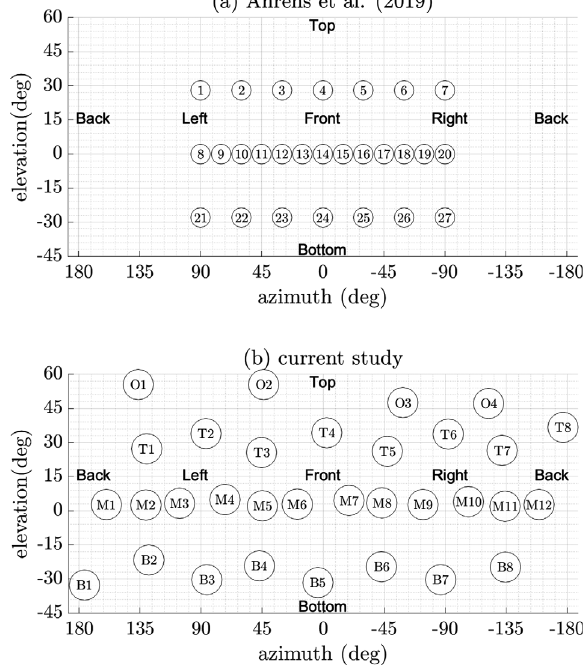
Figure 1. Audio source positions tested in (a) Ahrens et al. [3] and (b) current study. Coordinates are relative to participant ’ s head position. Orientation labels “ Back ” , “ Left ” , etc. have been moved up from 0 (cid:1) elevation for